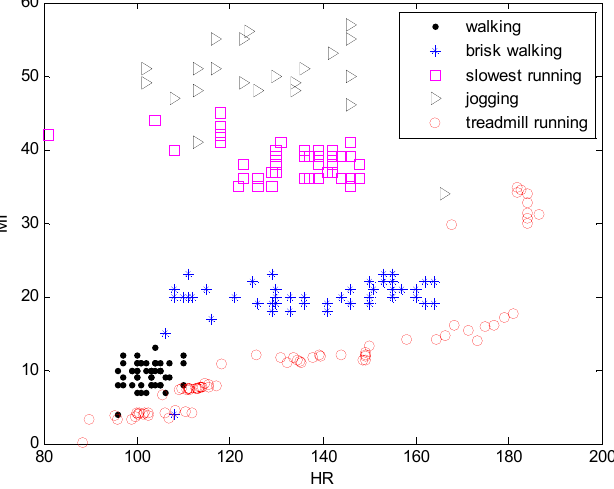
Figure 7. Distribution of two input variables obtained in indoor and outdoor